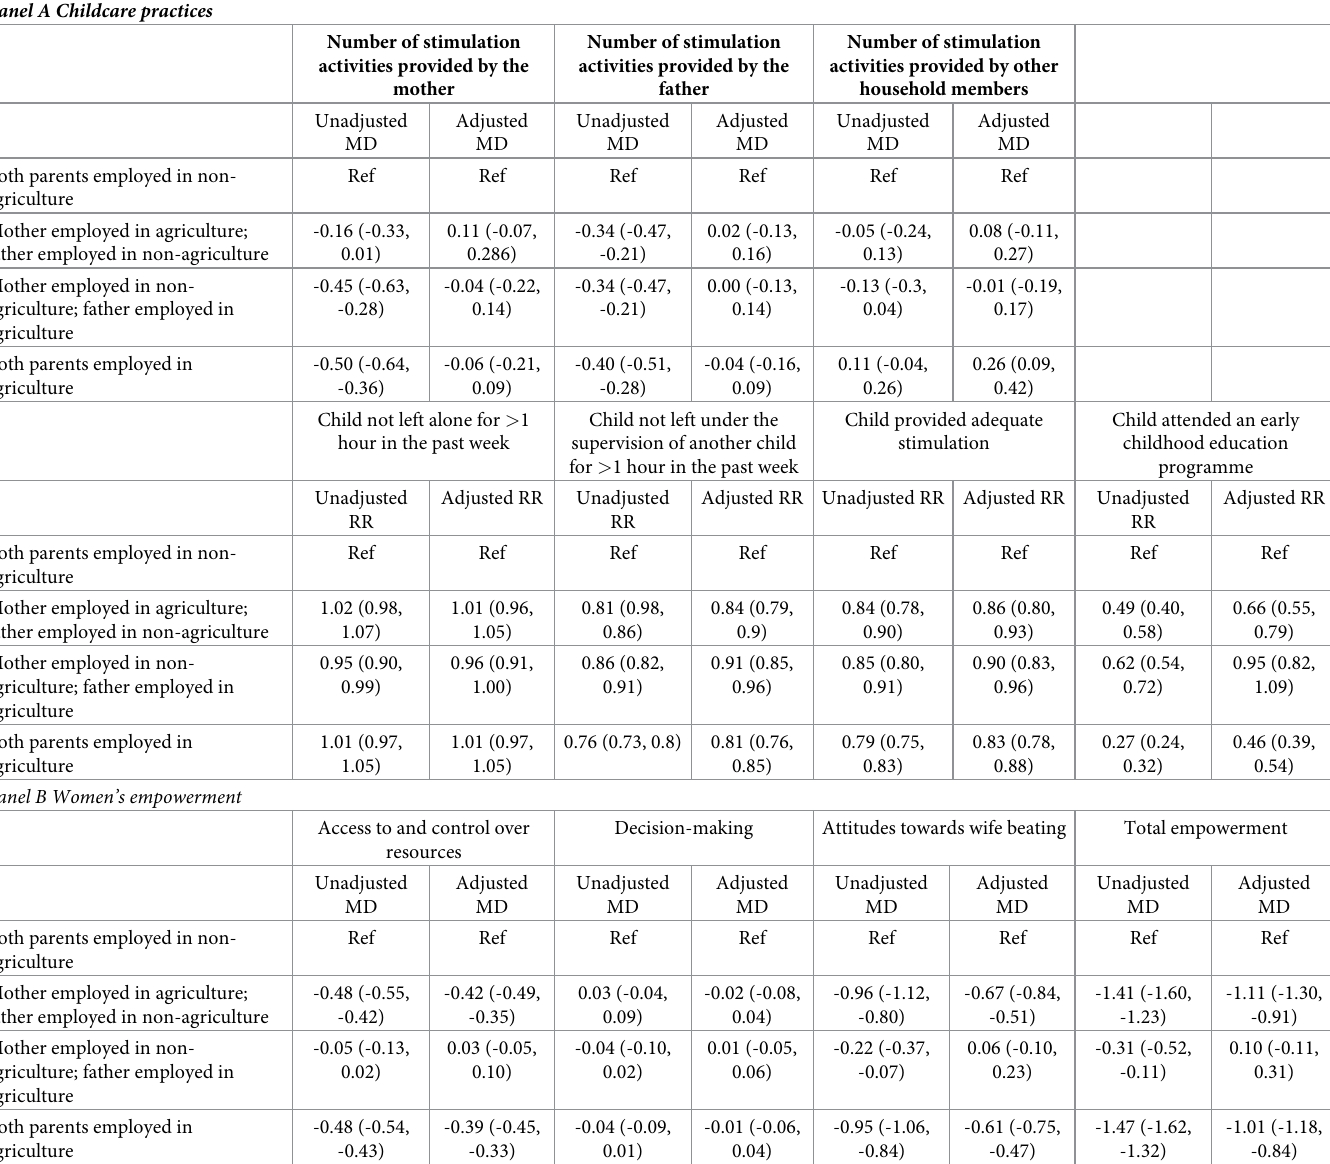
Table 4. Associations between parental occupation and childcare practices and women’s empowerment among children aged 36–59 months 1